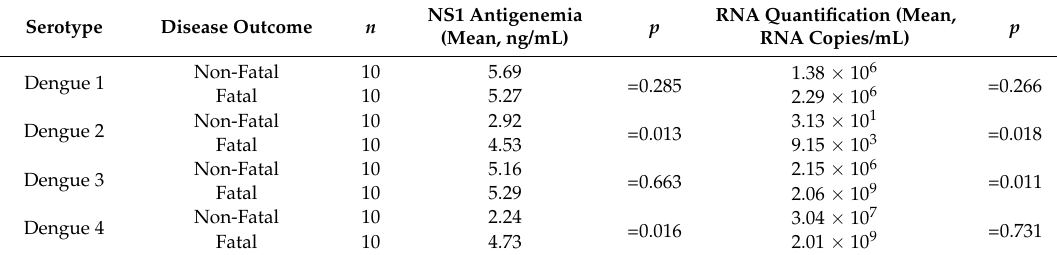
Table 2. NS1 antigenemia and RNA viral load according to the distinct DENV serotype and disease outcome. Serotype Disease Outcome n